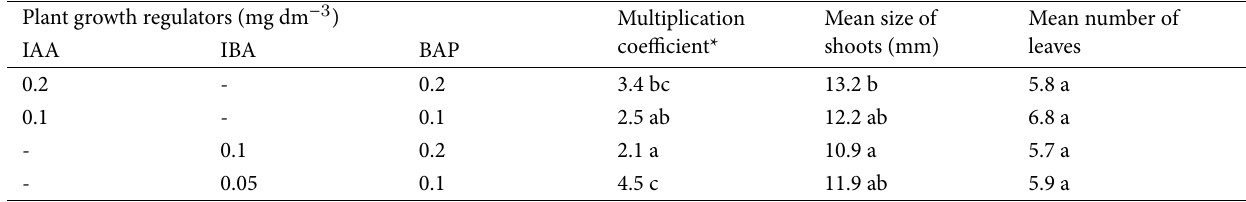
Table 3 Shoot multiplication of Primula farinosa on MS medium supplemented with BAP and IAA or IBA after 5 weeks of culture.